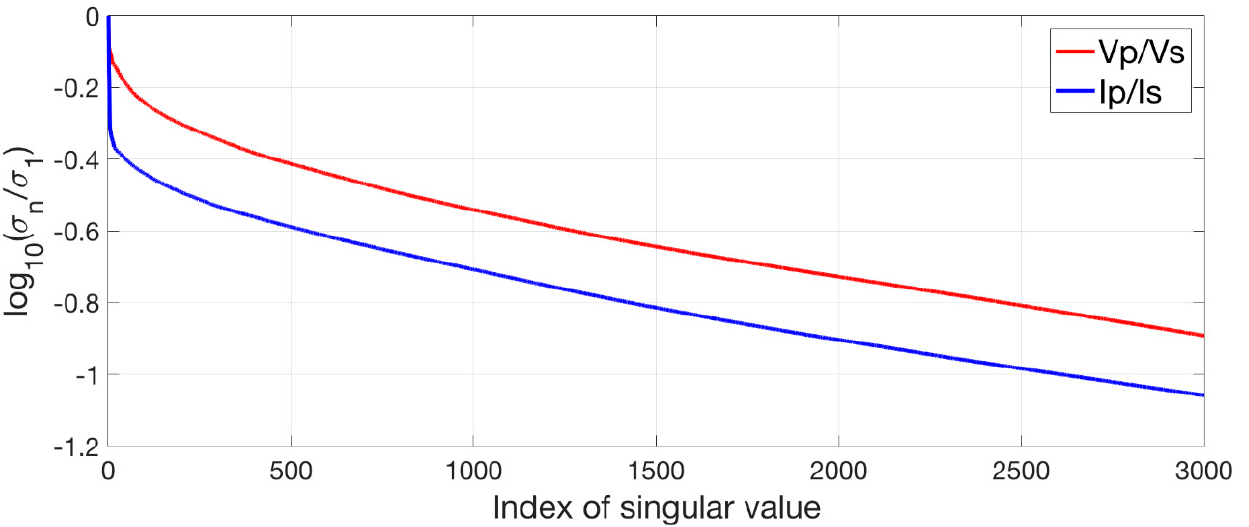
Figure 3. Singular spectra of linearised forward maps for parametrisation through velocities (red) and elastic impedances (blue). Linearised inverse problem for parametrisation Figure 3) in comparison with the case of elastic impedances.